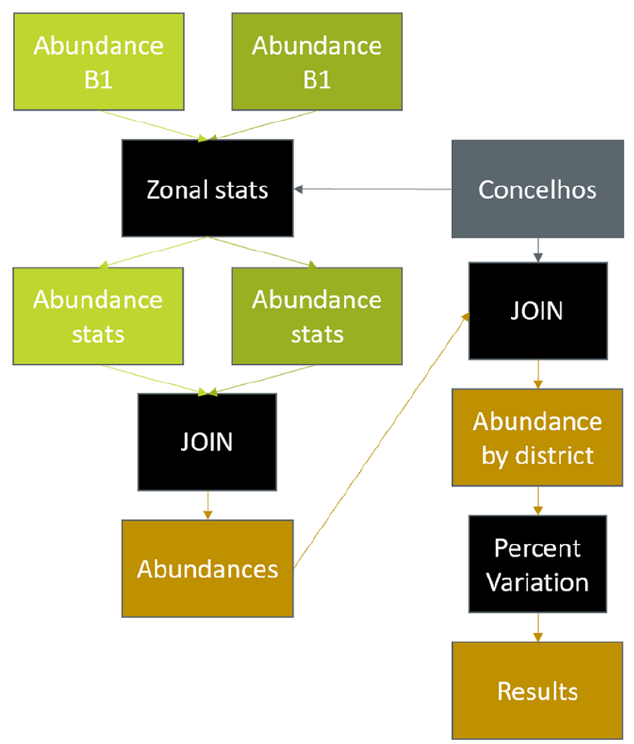
Figure 2. Schematic representation for analyzing the statistical comparison model flow.